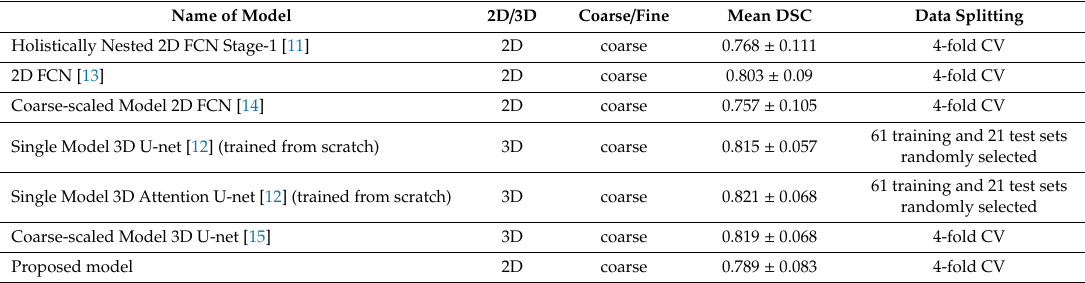
Table 3. Summary of coarse-scaled models using the Pancreas-CT